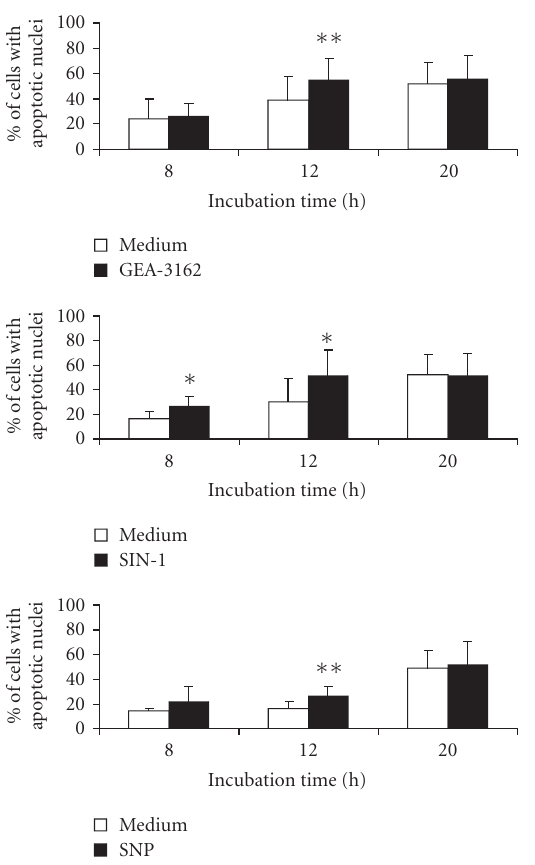
Figure 2. E ff ect of nitric oxide donors on neutrophil apoptosis in vitro measured by DNA content. Neutrophils (1 × 10 6 cells) were incubated at 37 ◦ C with indicated stimuli (closed bars) or in the medium (open bars) for 8, 12, and 20hours and apop- tosis was determined as described in “materials and methods.” Data are presented as the means and SD percentages of cells with apoptotic nuclei. Values are statistically significant: neu- trophils versus neutrophils with nitric oxide donors ( ∗ denotes that P = . 003, ∗∗ denotes that P = .